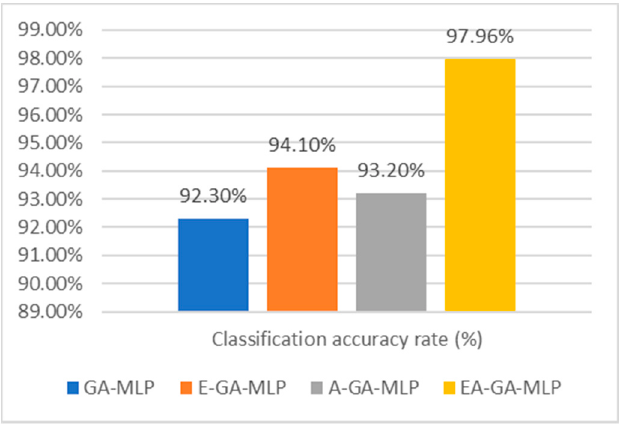
Figure 5. Comparative analysis of accuracy rate of presented algorithm EAGA with its subcomponents.